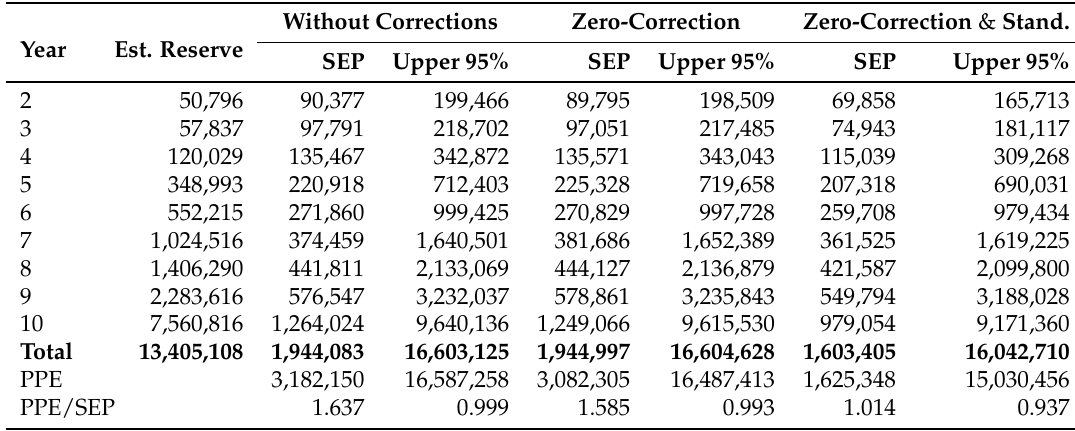
Table 3. Over-dispersed Poisson model with Pearson residuals.